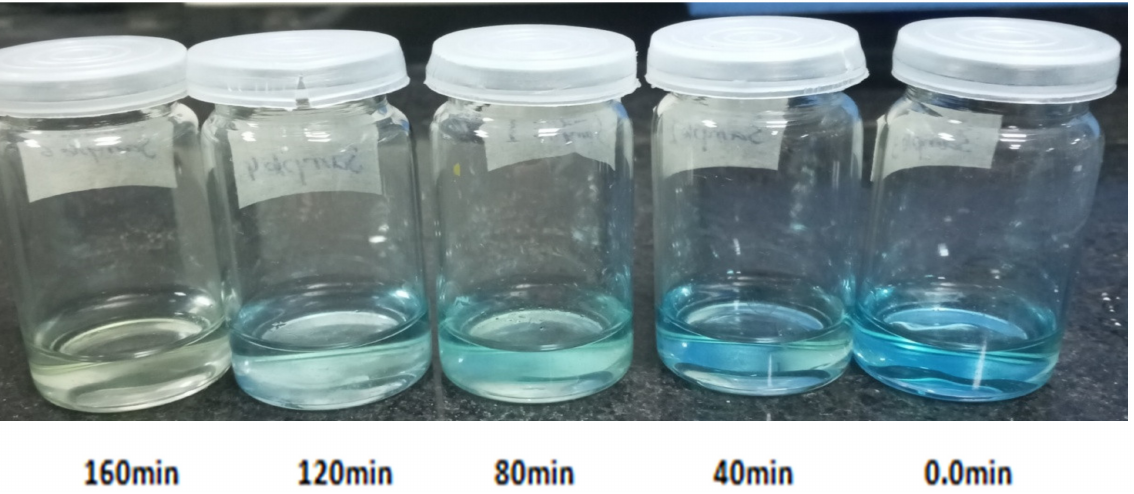
Figure 8. Change in color depth during dye degradation.